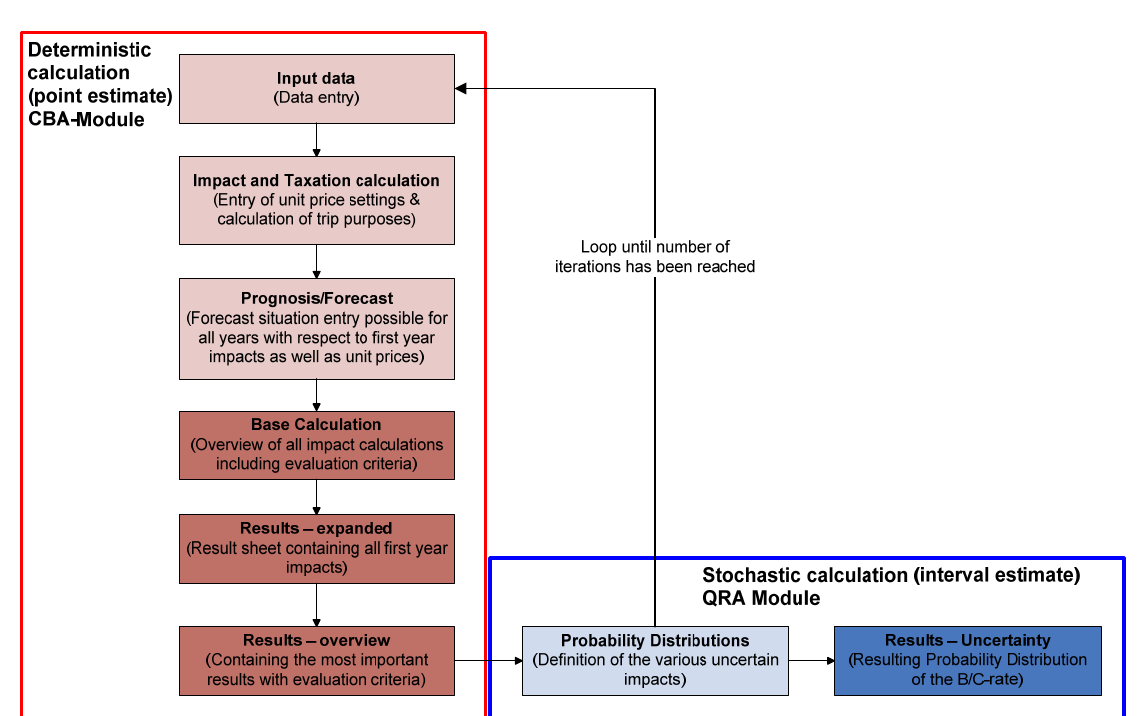
Figure 5. The feasibility risk assessment procedure composed by the CBA and QRA approaches to informed decision support (Salling